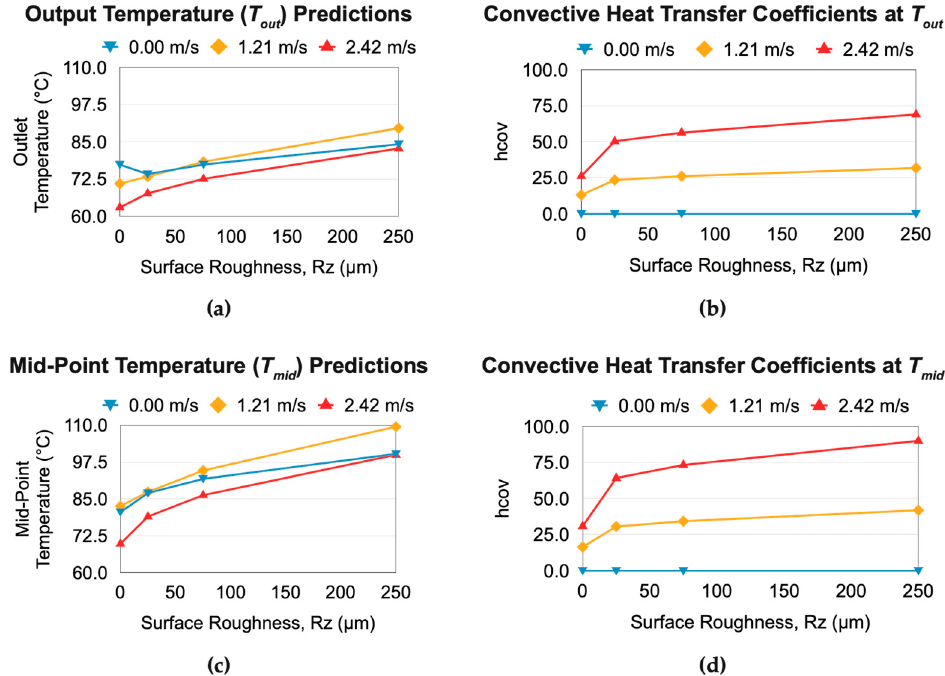
Figure 9. The predicted temperatures and convective heat transfer coefficients: ( a ) Output Temperature ( T out ) Predictions; ( b ) Convective Heat Transfer Coefficients at T out ; ( c ) Mid ‐ Point Temperature ( T mid ) Predictions; ( d ) Convective Heat Transfer Coefficients at T mid .